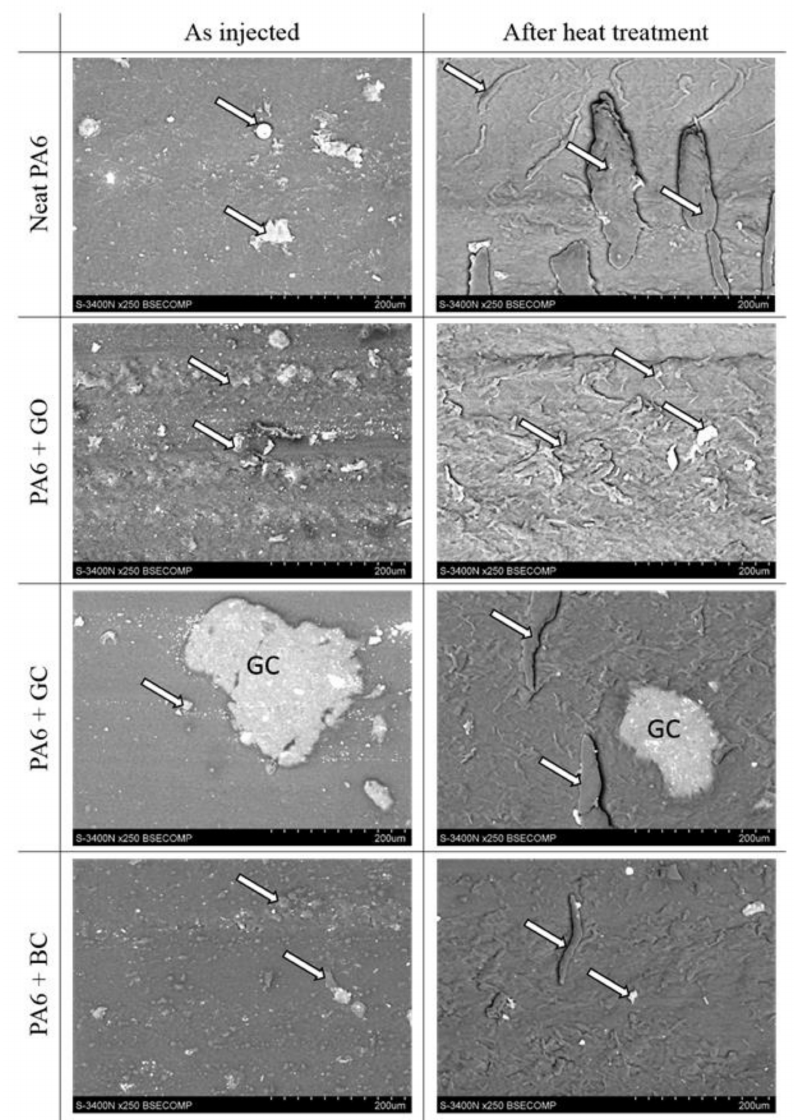
Figure 11. SEM micrographs of PA6 and its composites’ wear tracks after friction tests; friction products indicated by